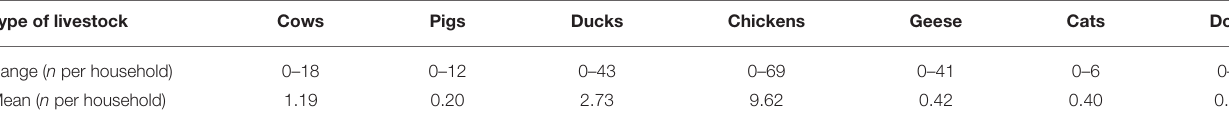
TABLE 7 | The range and mean of household livestock assets on the Masoala Peninsula (2015). Type of livestock Cows Pigs Ducks Range ( n per household) Mean ( n per